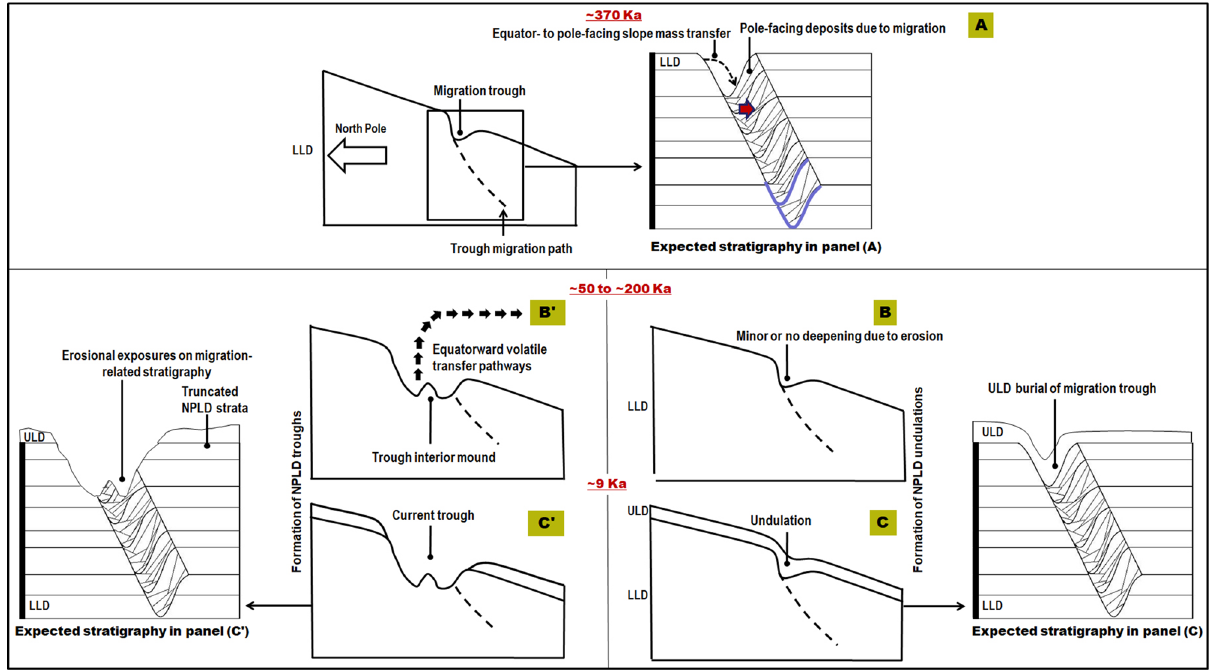
Figure 7. Sketches depicting how poleward trough migration could have shaped the NPLD stratigraphy associated with undulations ( A – C ), and trough interior stratal truncation morphologies ( A – C’ ). ( A ) Following Mars’ last ice age ~ 370 Ka as proposed by Smith et al. 13 , polar ice accumulation during low mean obliquity led to the emplacement of the top few hundred meters of the LLD, concurrently with the poleward migration of troughs, which resulted in the formation of radar detectable migration pathways. The indigo lines trace